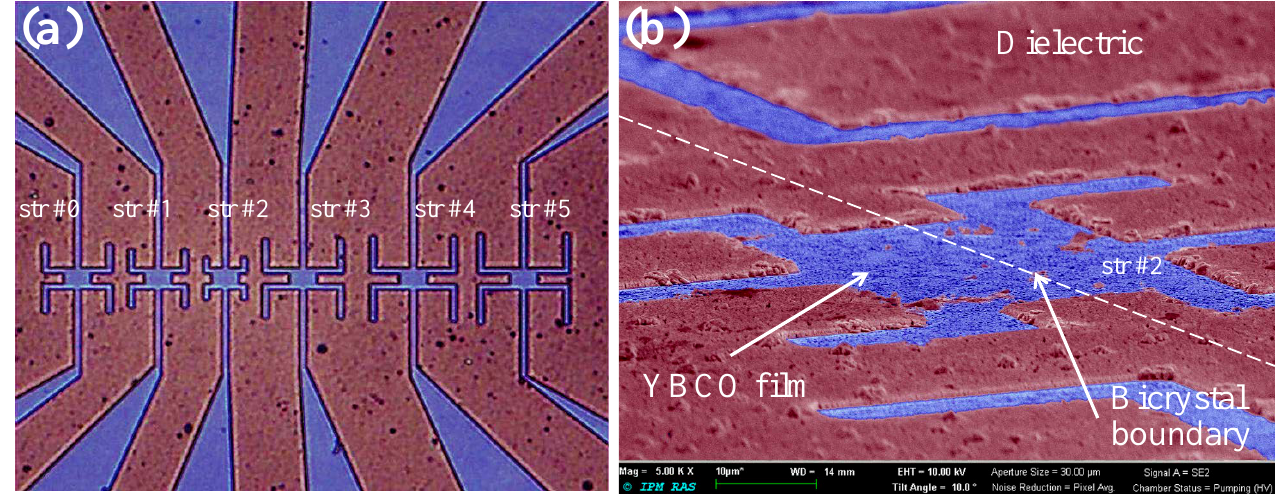
Figure 1. Photograph ( a ) and SEM image ( b ) of a sample with structures of YBCO JJ